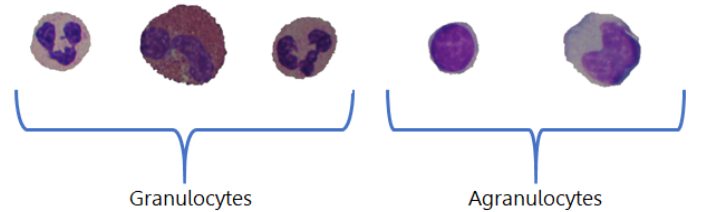
Figure 2. The five types of WBCs: basophil, eosinophil, neutrophil, lymphocyte, and monocyte. There exist two main groups of leukocytes: the granulocytes and the agranulocytes. The granulocytes contain granules inside the cytoplasm. They are neutrophils, eosinophils, and basophils and have a multilobed nucleus. The agranulocytes include lymphocytes and monocytes; they do not contain granules and have non-lobular